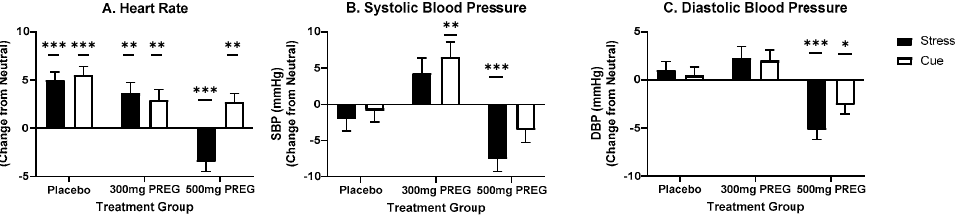
Figure 5. Pregnenolone effects on heart rate, systolic blood pressure and diastolic blood pressure. ( A ) Heart rate (HR) increased in response to stress and cocaine cue compared to the neutral condition in both the PBO group (S > N, p < 0.001; C > N, p < 0.001) and the 300 mg PREG group (S > N, p = 0.003; C > N, p = 0.02) and in response to cocaine cue in the 500 mg PREG group ( p = 0.09), while it was significantly reduced in the stress condition compared to the neutral condition ( p < 0.001) in the 500 mg PREG group. ( B ) Systolic blood pressure (SBP) increased significantly in response to the cocaine cue condition compared to the neutral condition ( p = 0.003) in the 300 mg PREG group while it decreased significantly in the stress compared to neutral condition ( p < 0.001) in the 500 mg PREG group. ( C ) Diastolic blood pressure (DBP) was significantly decreased in the stress condition ( p < 0.001) and cocaine cue condition ( p = 0.02) compared to neutral in the 500 mg PREG group. All data are displayed as mean ± S.E.M. *Significance represents condition relative to neutral. *p < 0.05; ** p < 0.01; *** p < 0.001